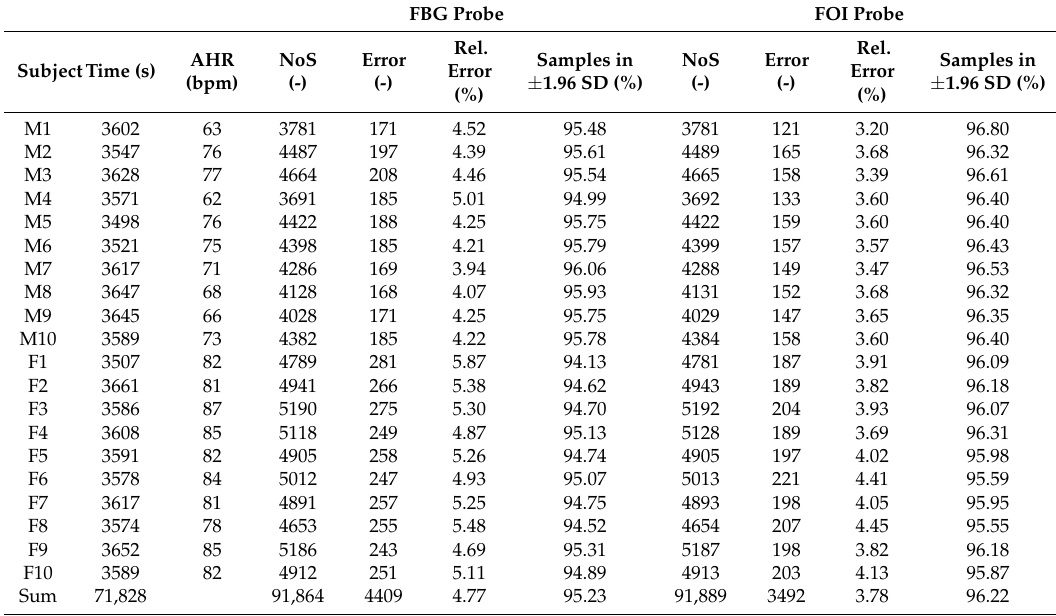
Table 4. Summary of heart rate